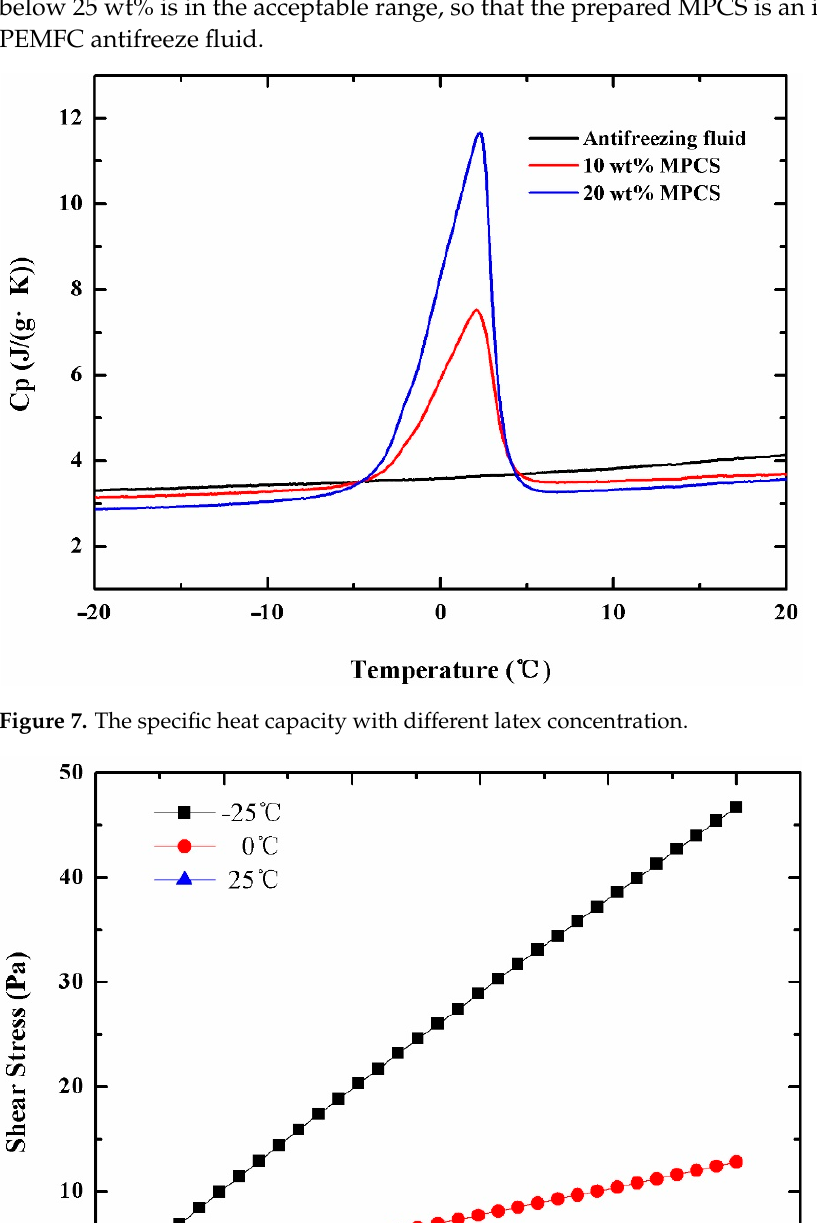
Figure 6. The DSC curves of MPCM and pure PCM during phase transition.